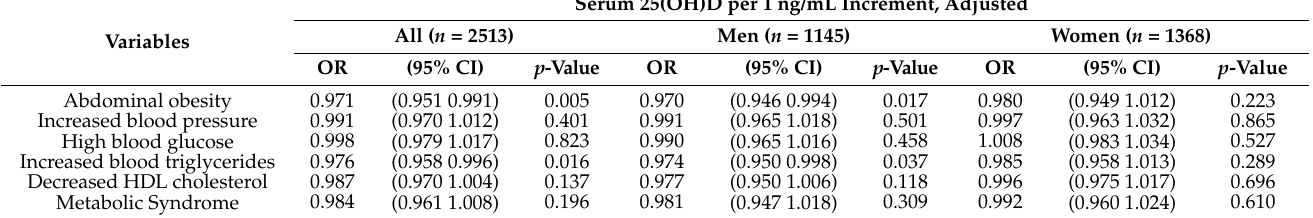
Table 4. Odds ratios for metabolic syndrome and associated factors by serum 25-hydroxyvitamin D (25(OH)D) concentration and gender.